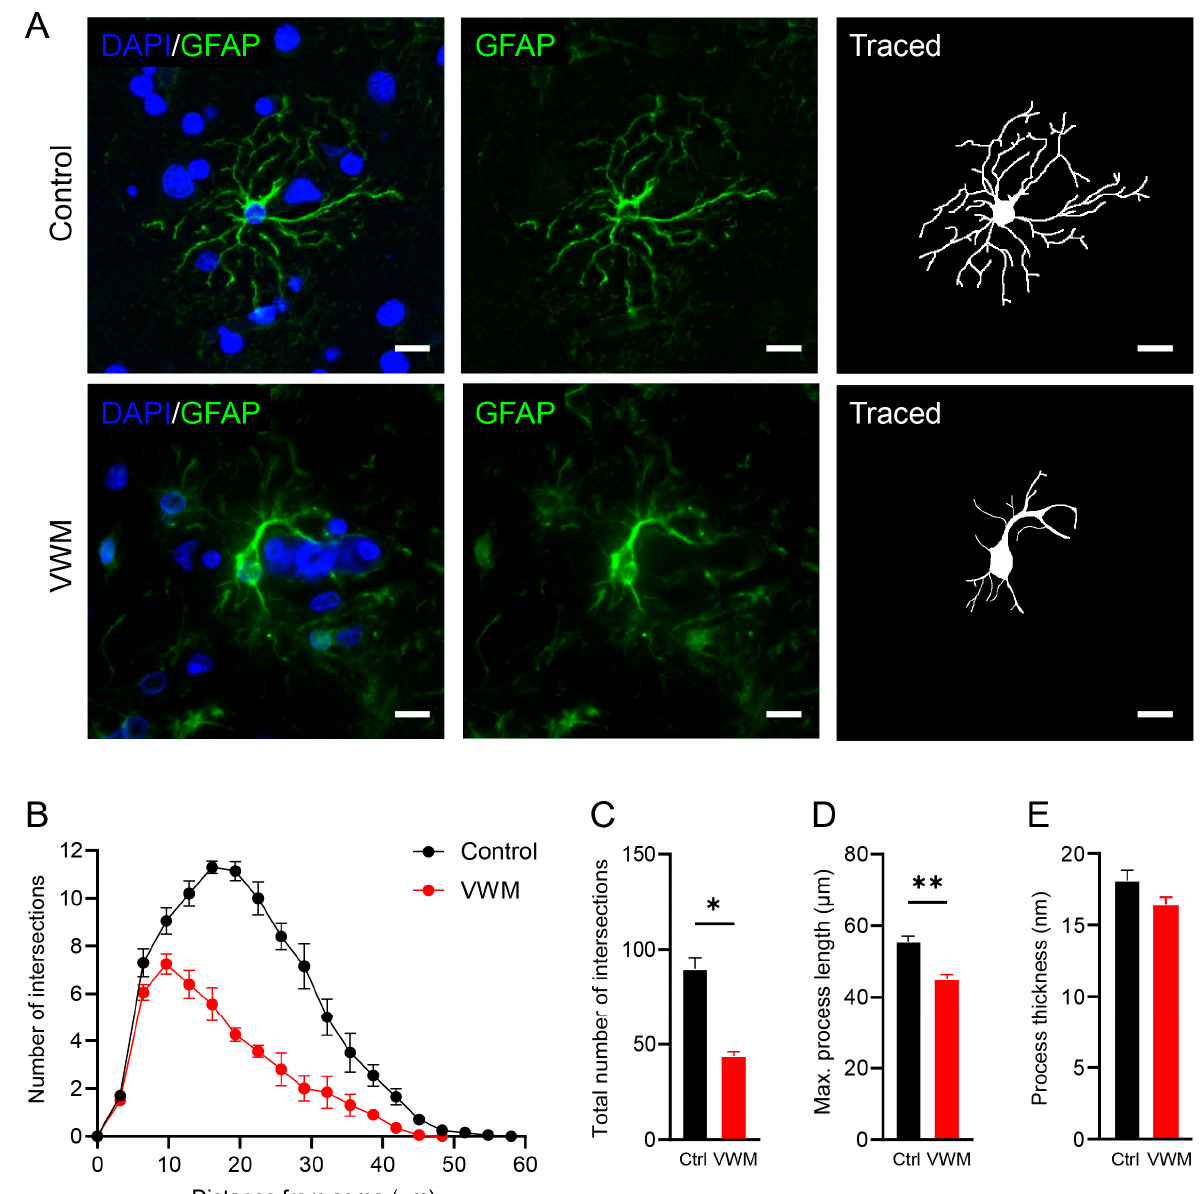
Figure 7. Astrocytes in the VWM cortex show reduced morphological complexity. ( A ) Immunostaining of control and VWM cortices showing GFAP-positive astrocytes (green) and their respective tracings. Blue stain indicates nuclei. Scale bars: 10 µm. Depicted images are stains of cortical tissue of control 1 and VWM 1. ( B ) Sholl diagram of astrocytes in the cortex of control and VWM brains. Diagram shows number of processes intersecting with concentric rings per 3 µm, starting from the cell body. ( C ) Total number of intersections. ( D ) Maximum process length. ( E ) Process thickness. * p -value < 0.05, ** p -value < 0.01.